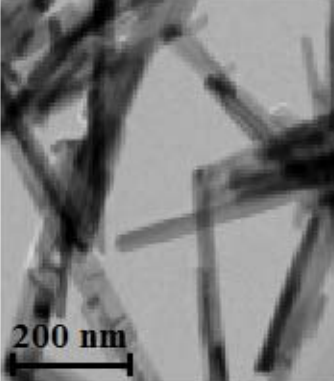
Fig. 5. TEM image of nanorod structure of pure